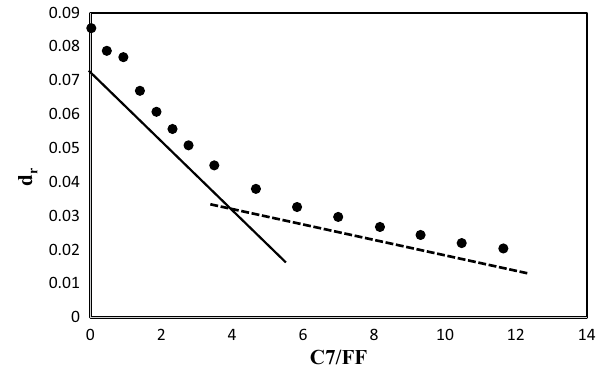
Fig. 20 Reduced density of fluid FF {crude oil F (5 g) + cyclohexane (7.5 g) + n -heptane ( X g )} as a function of the ratio of n -heptane and available crude oil (Ekulu et al. 2010)